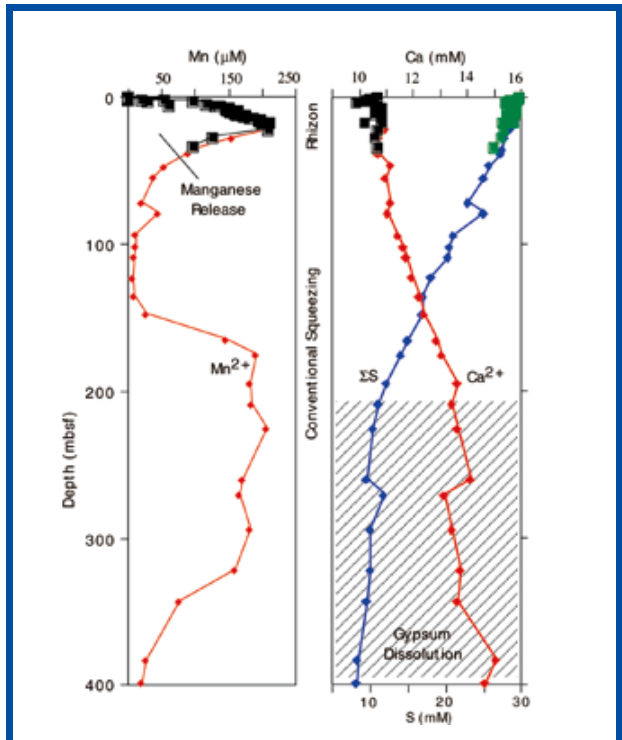
Figure 4. Pore-water concentration profiles (by Jerry